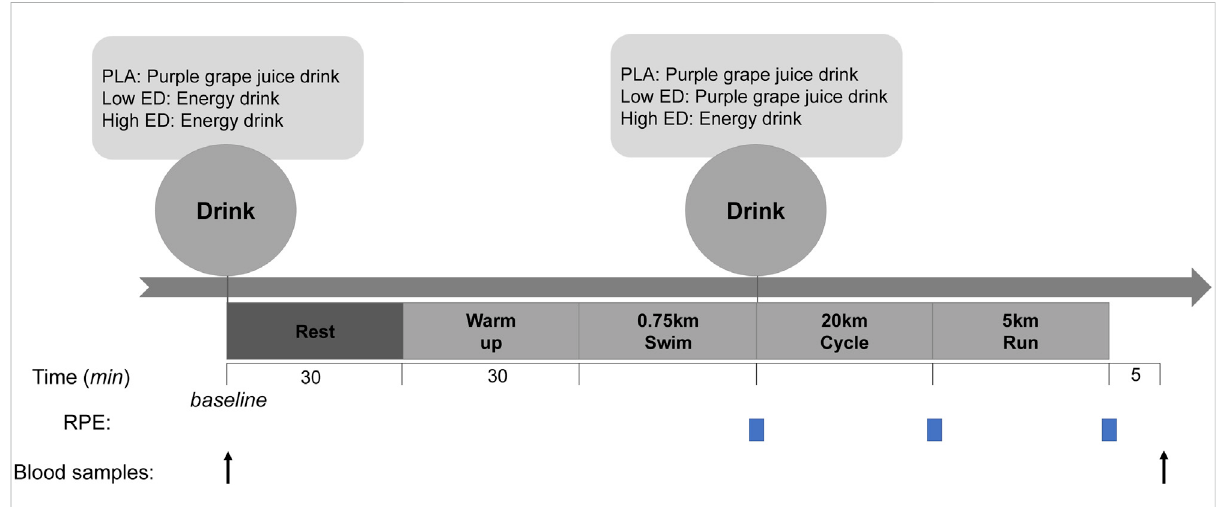
FIGURE 1 Study protocol and